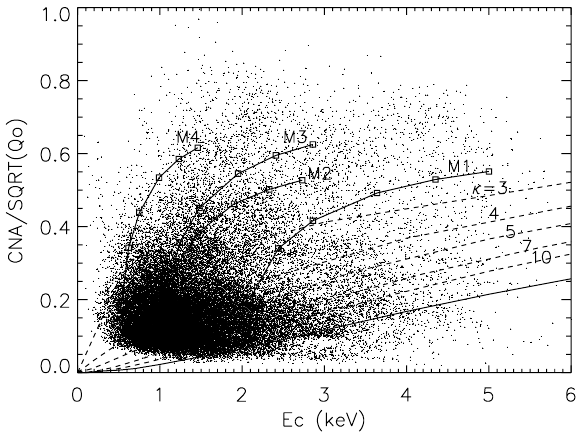
Fig. 5. Scatter plot of CNA against characteristic energy E c for all 79-day observations selected from the data set from 1996 to 1998. The format of this figure is the same as that of Figs. 2 and 4. The solid line in the figure represents the theoretically estimated curve with Maxwellian distribution assumed as the energy distri- bution of precipitating electrons. Most observations show a wide distribution significantly above the predicted curve. The five bro- ken lines in the figure represent the theoretically estimated curve from kappa distributions ( κ index of 3, 4, 5, 7 and 10) for the en- ergy distribution of precipitating electrons. The solid lines with squares labeled M1, M2, M3, and M4 show the CNA calculated from double Maxwellian distributions. The parameters for the dou- ble Maxwellians are ( E 1 is the peak of the low energy, E 2 is the peak of the high energy Maxwellian) M1: E 1 =2keV, E 2 =20keV; M2: E 1 =1keV, E 2 =20keV; M3: E 1 =1keV, E 2 =40keV; M4: E 1 =0.5keV, E 2 =40keV. The ratio of the energy flux between the low and high energy Maxwellian was varied from 20 to 0.5 to give the plotted variation of the characteristic